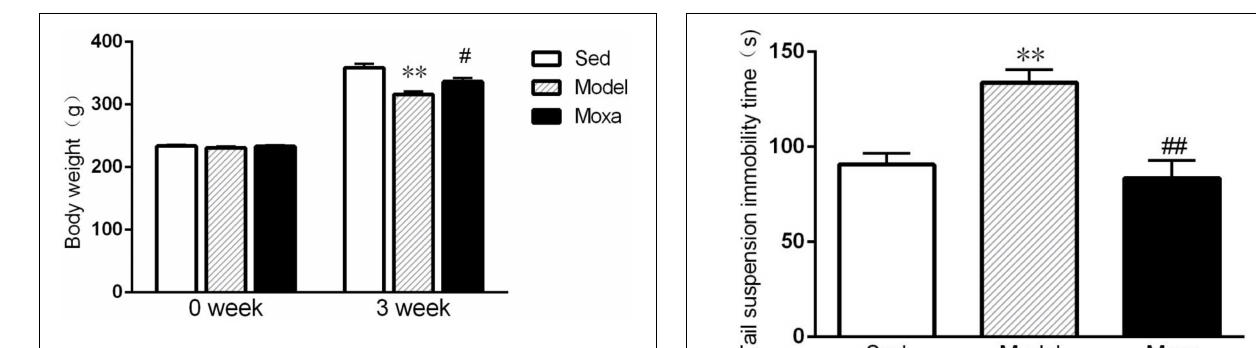
(120.875 ± 15.06 cm vs.168.875 ± 16.13 cm; P < 0.05).